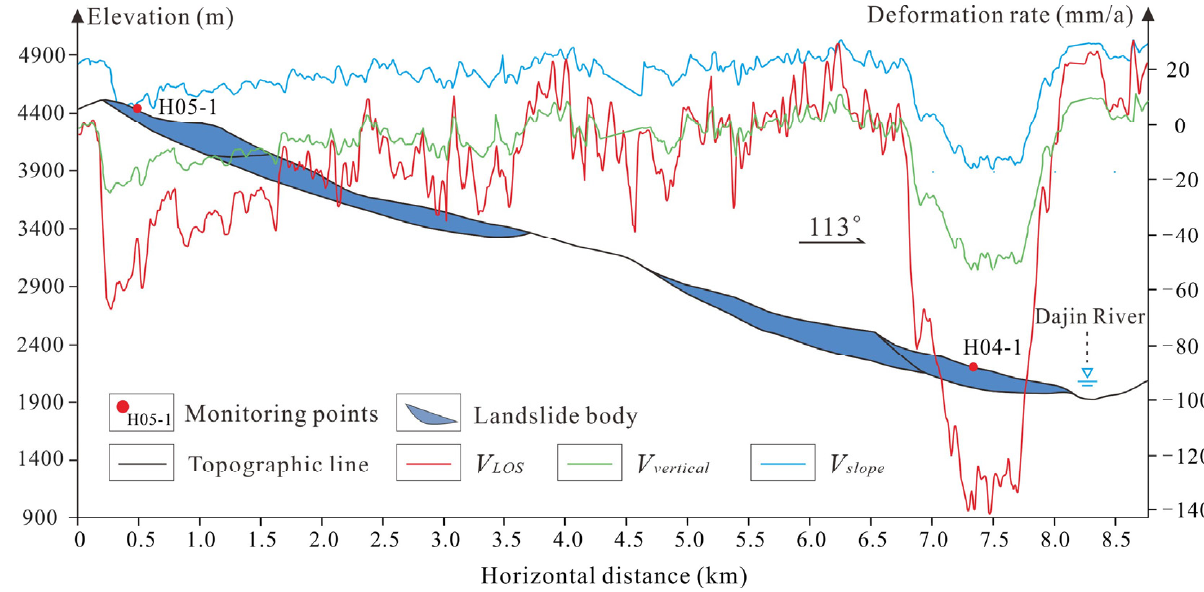
Figure 7. Deformation rate along the A ‐ A’ profile (A ‐ A’ profile in Figure 2b).